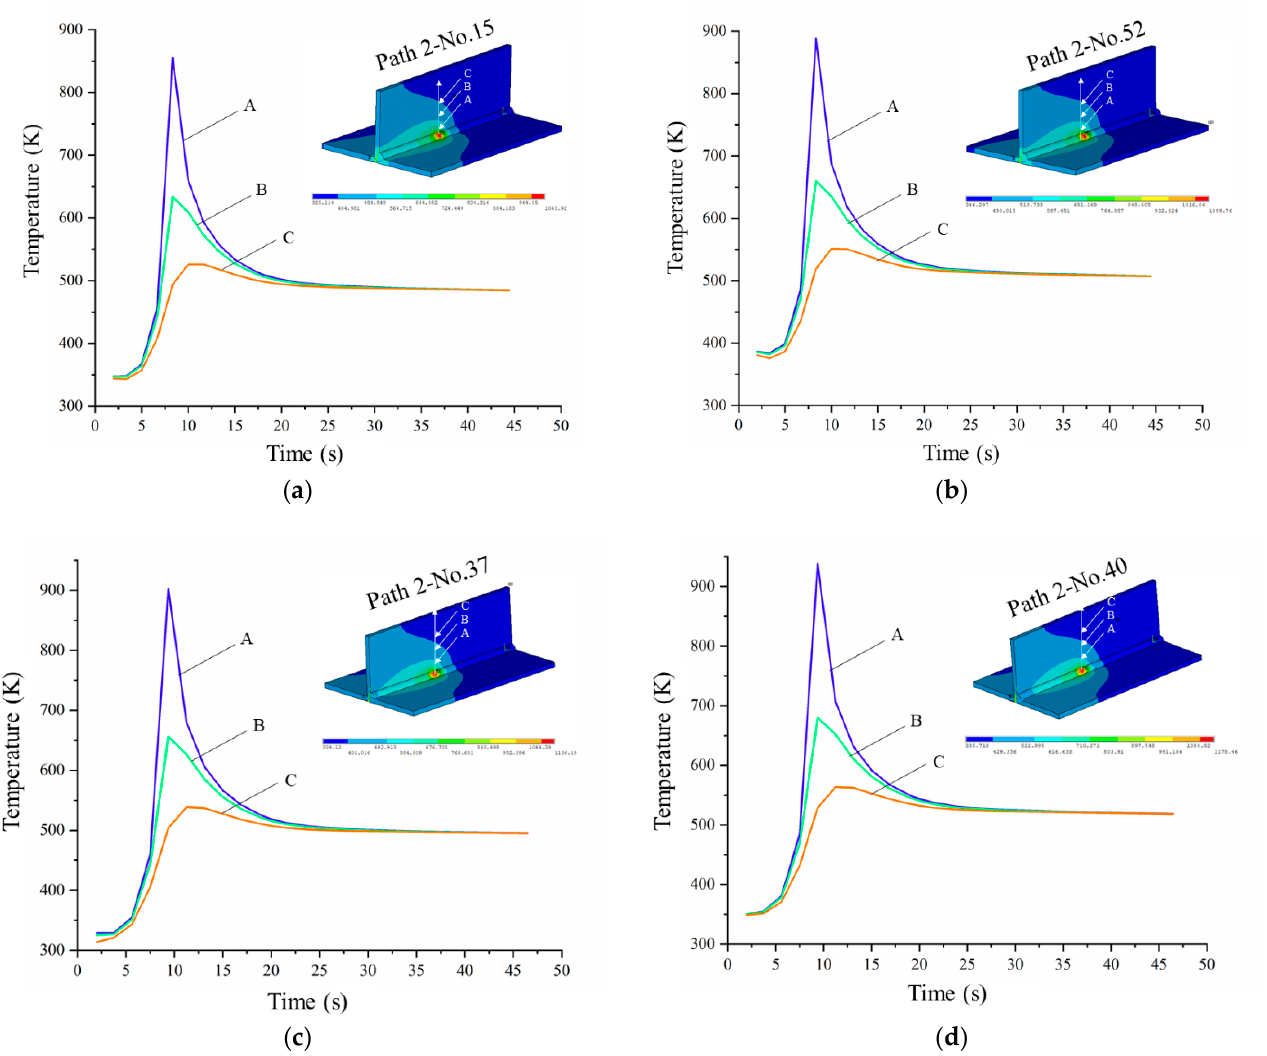
Figure 11. Temperature curves of tracking points at different preheat temperatures and areas. ( a ) Temperature curves of group 15; ( b ) temperature curves of group 52; ( c ) temperature curves of group 37; ( d ) temperature curves of group 40.